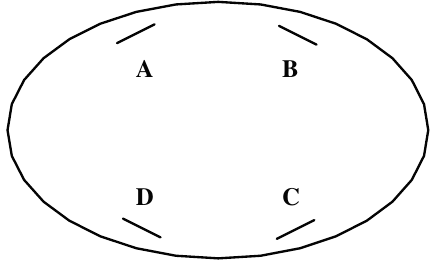
FIG. 8. BPM buttons ( A; D : inboard side of the ring; B; C : outboard